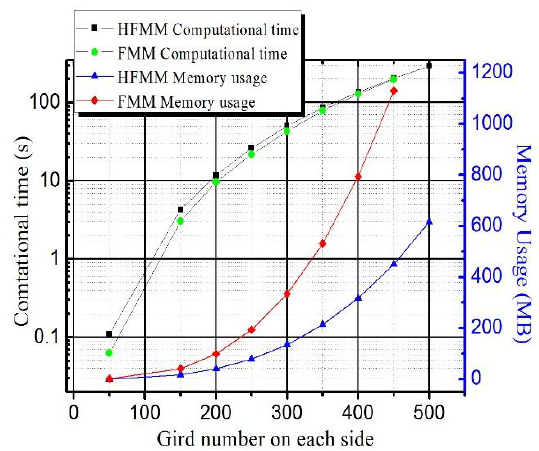
Figure 6. Comparisons of the running time and memory usage of the original fast marching method (FMM) and the full hash fast marching method (HFMM) on different grid sizes using a typical dissolution rate function F = 2(( x − 0.5) 2 + ( y − 0.5) 2 ).